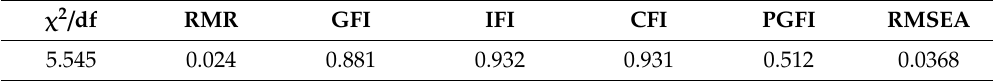
Figure 2. Simulated hypothesis model of SA, SL and SCB. Table 5. Model fitting index for SA, SL and SCB measurement